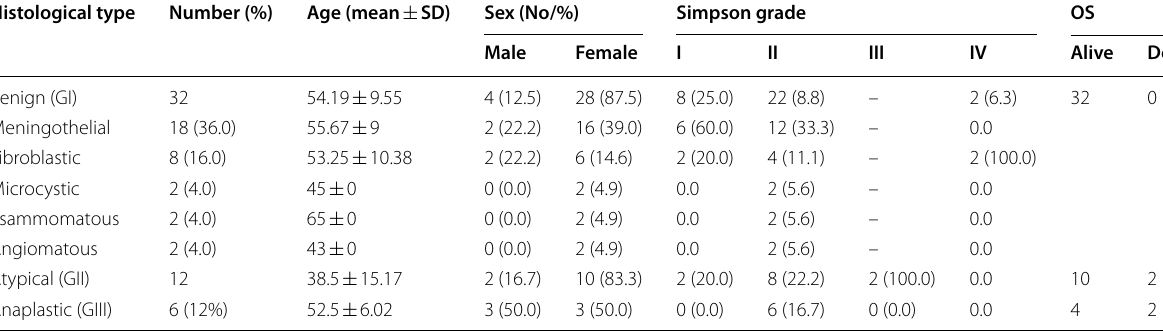
Table 1 Clinical characteristics of patients with intracranial meningiomas: Histological